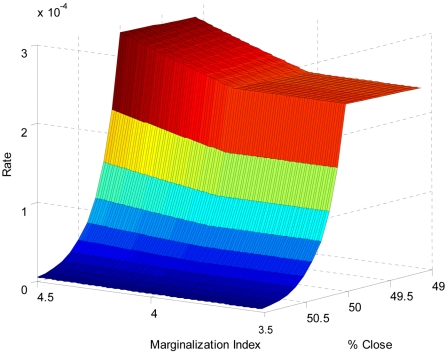
Breakpoints and discontinuous patterns of association.A schematic representation of the breakpoint in marginalization (MI) and people living close to the forest (%close), when minimum elevation (ME) is set to 500 m and rainfall (log(MinRfll)) is set at its breakpoint. The surface illustrates major qualitative differences in disease risk as a function of the covariates. Specifically, risk increases exponentially as the proportion of people living close to the forest decreases above the breakpoint. The change has the opposite sign and decreases in magnitude for smaller values below the breakpoint. Marginality exacerbates this difference above its own breakpoint. Parameters are those of the model selected as best. This model has 7 parameters (AIC = 5768.7) and fits the data satisfactorily (Residual deviance = 79.718, df = 72, P>0.24), explains 71.34% of the deviance (null deviance = 278.108) and is not different from the more complex models presented in Table 1, values for the coefficients are presented in Table S6.